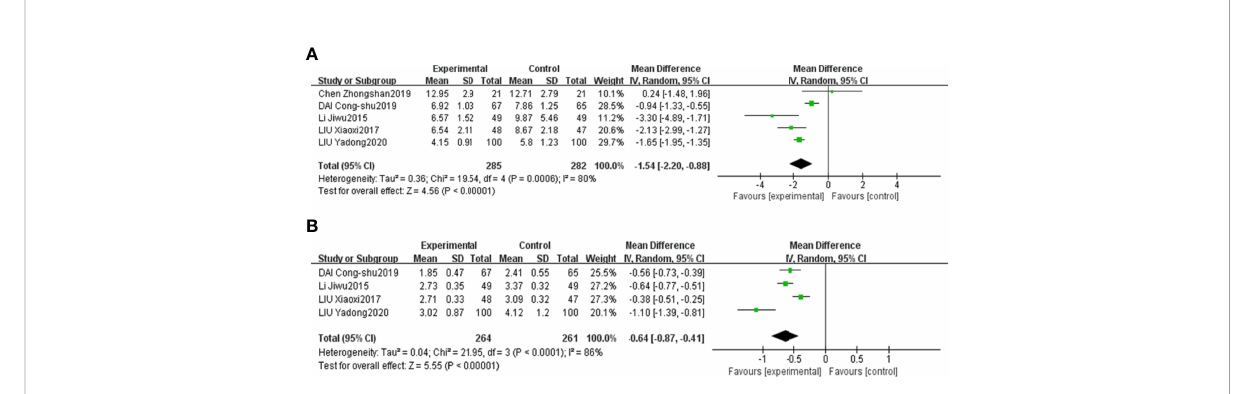
FIGURE 7 Forest plots of FINS (A) and HOMA-IR (B) for the comparison of CHF+metformin treatment versus metformin